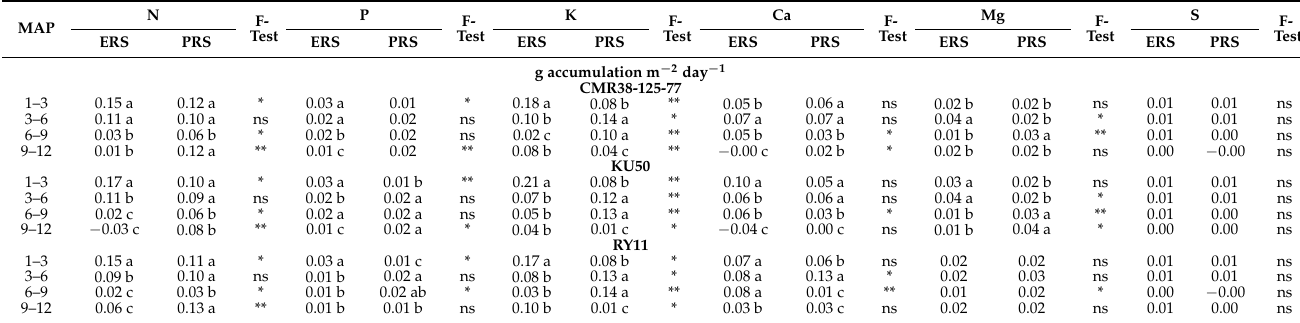
Table 3. Nutrient accumulation rates (g accumulation m − 2 day − 1 ) of three cassava genotypes in the early rainy seasons (ERS) and post rainy seasons (PRS) with full